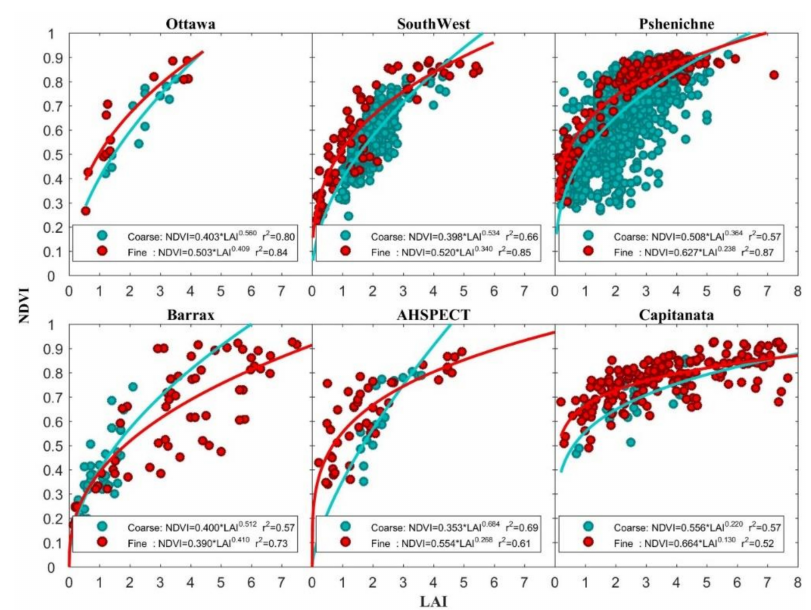
Figure 3. Normalized Di ff erence Vegetation Index (NDVI)-LAI statistical models of the 6 cropland sites. The red points represent the (LAI, NDVI) dataset with 30 m spatial resolution, the red curves represent the model f ( p ) at 30 m spatial resolution, the aquamarine points represent the (LAI, NDVI) dataset with 1 km spatial resolution and the aquamarine curves represent the model F ( P ) at 1 km spatial resolution.